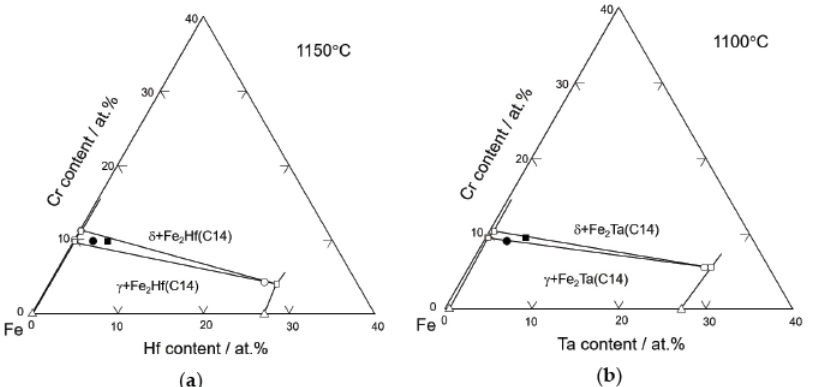
Figure 3. Isothermal sections of phase diagram showing the tie-triangle of δ , γ and Fe 2 M in the Fe-Cr-M (M: Hf, Ta) ternary systems: ( a ) Fe-Cr-Hf, 1150 °C, ( b ) Fe-Cr-Ta, 1100 °C.